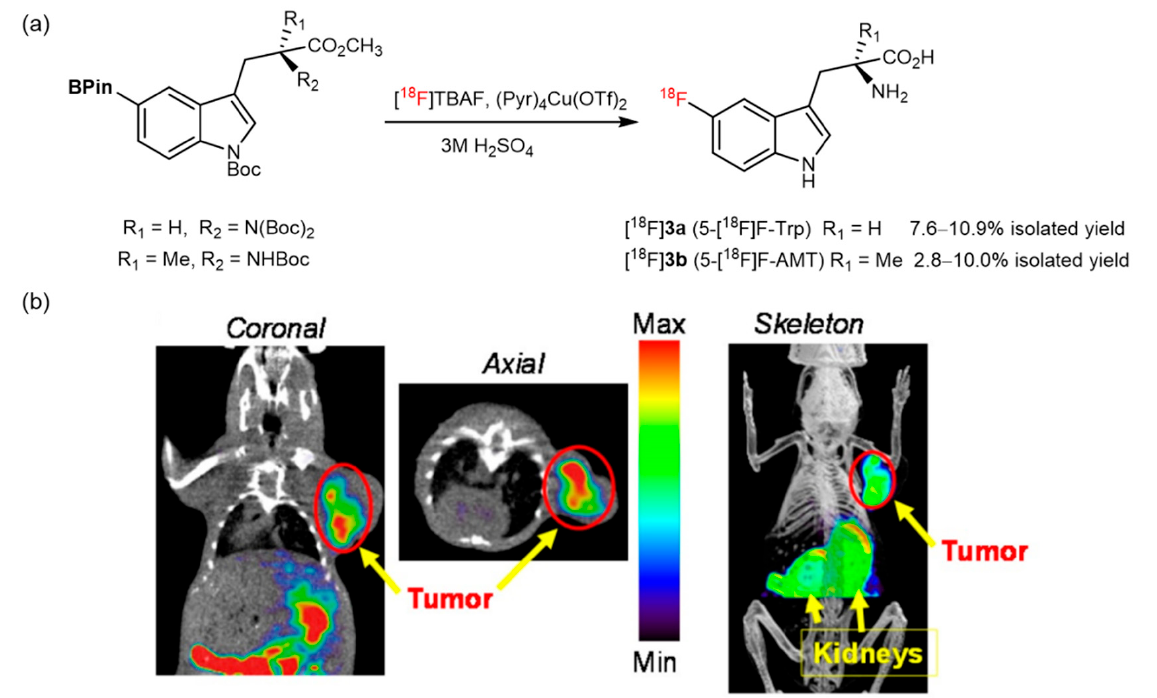
Figure 3. ( a ) Synthetic route of [ 18 F] 3a and [ 18 F] 3b . Modified from Giglio et al. [38]. ( b ) Decay corrected